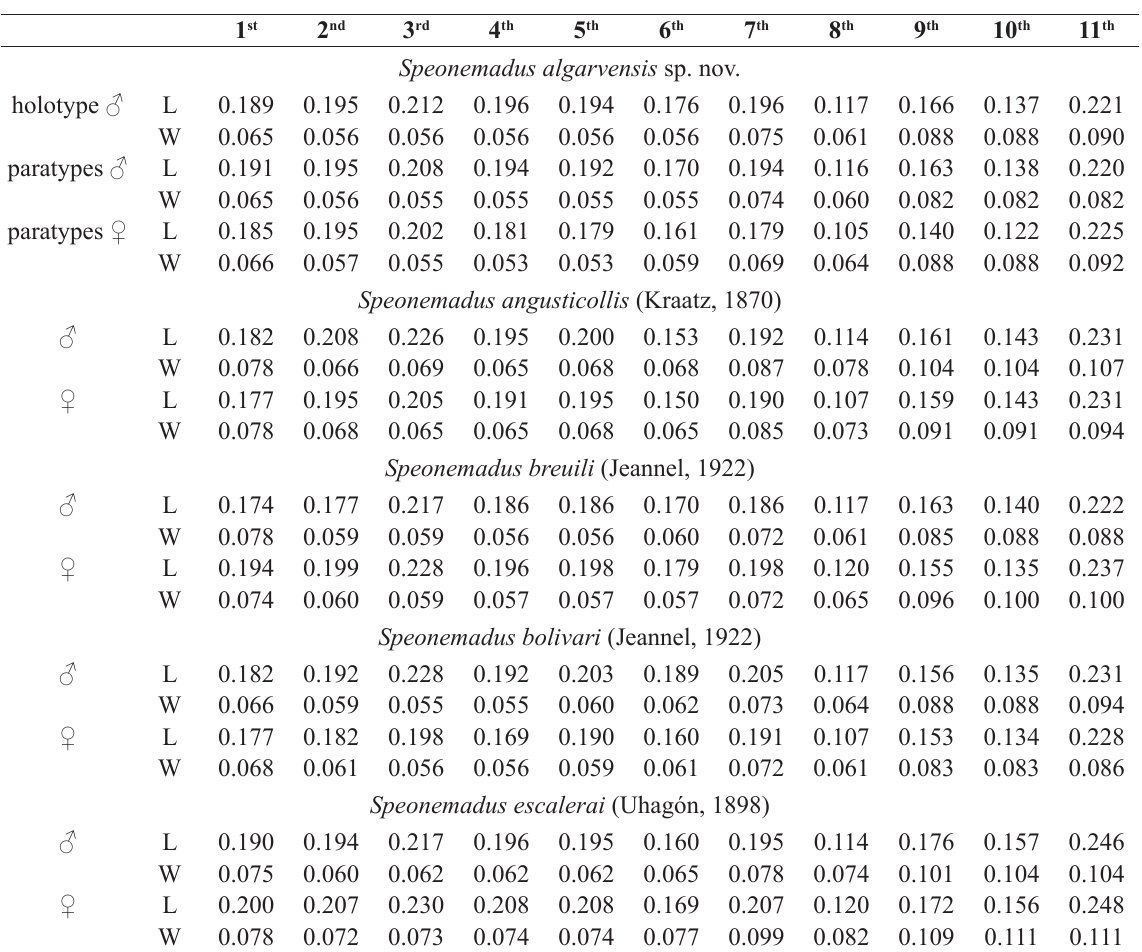
Table 1. Mean measurements (in millimeters) of the antennomers of Speonemadus of the escalerai - group (L) length; (W)